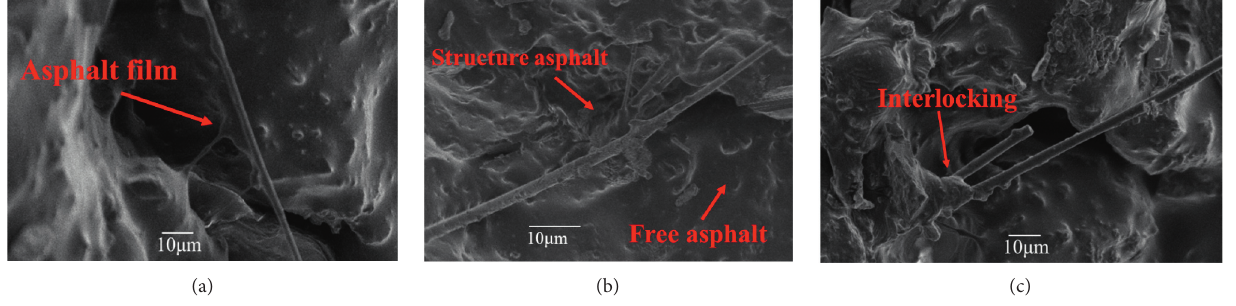
Figure 14: Adsorption of ceramic fibers.